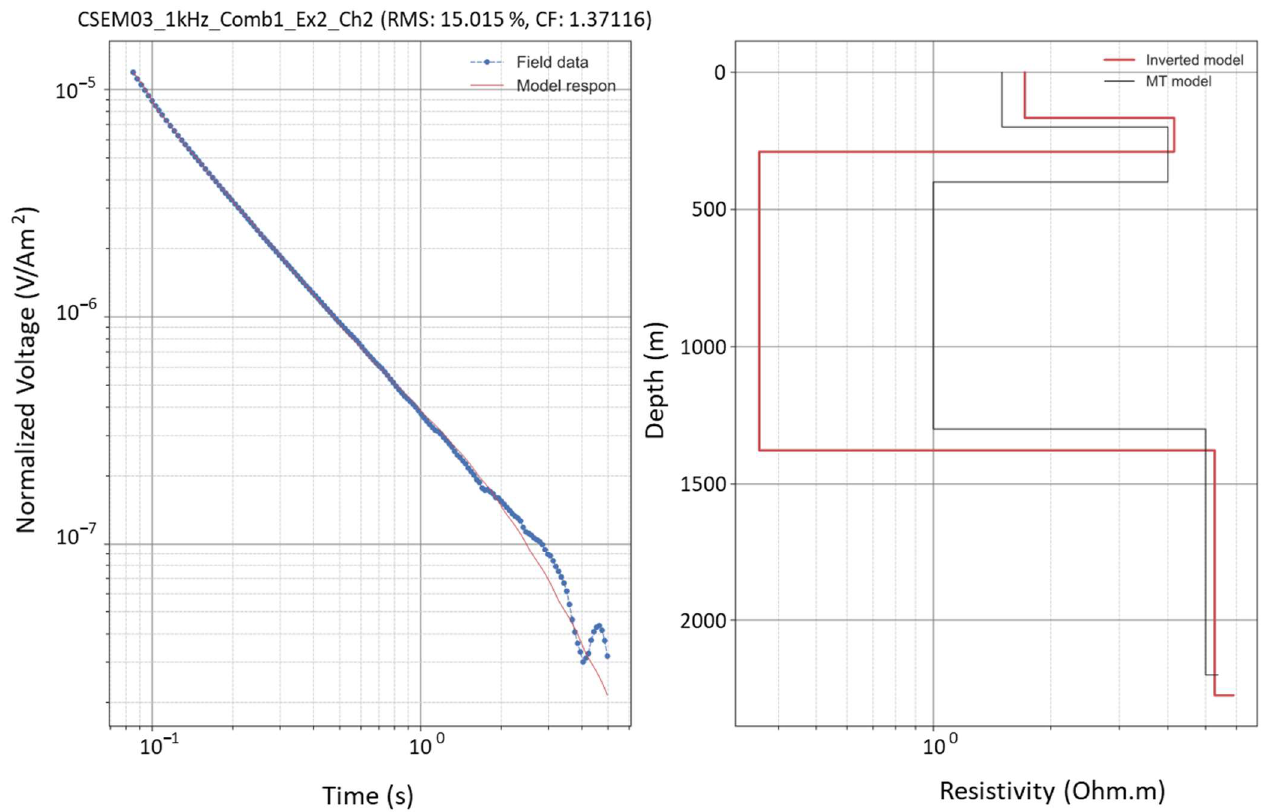
Figure 13. The LOTEM inversion data fit ( left ), and the comparison between LOTEM and MT inversion results ( right ) for the electric field in ST-03 are presented.